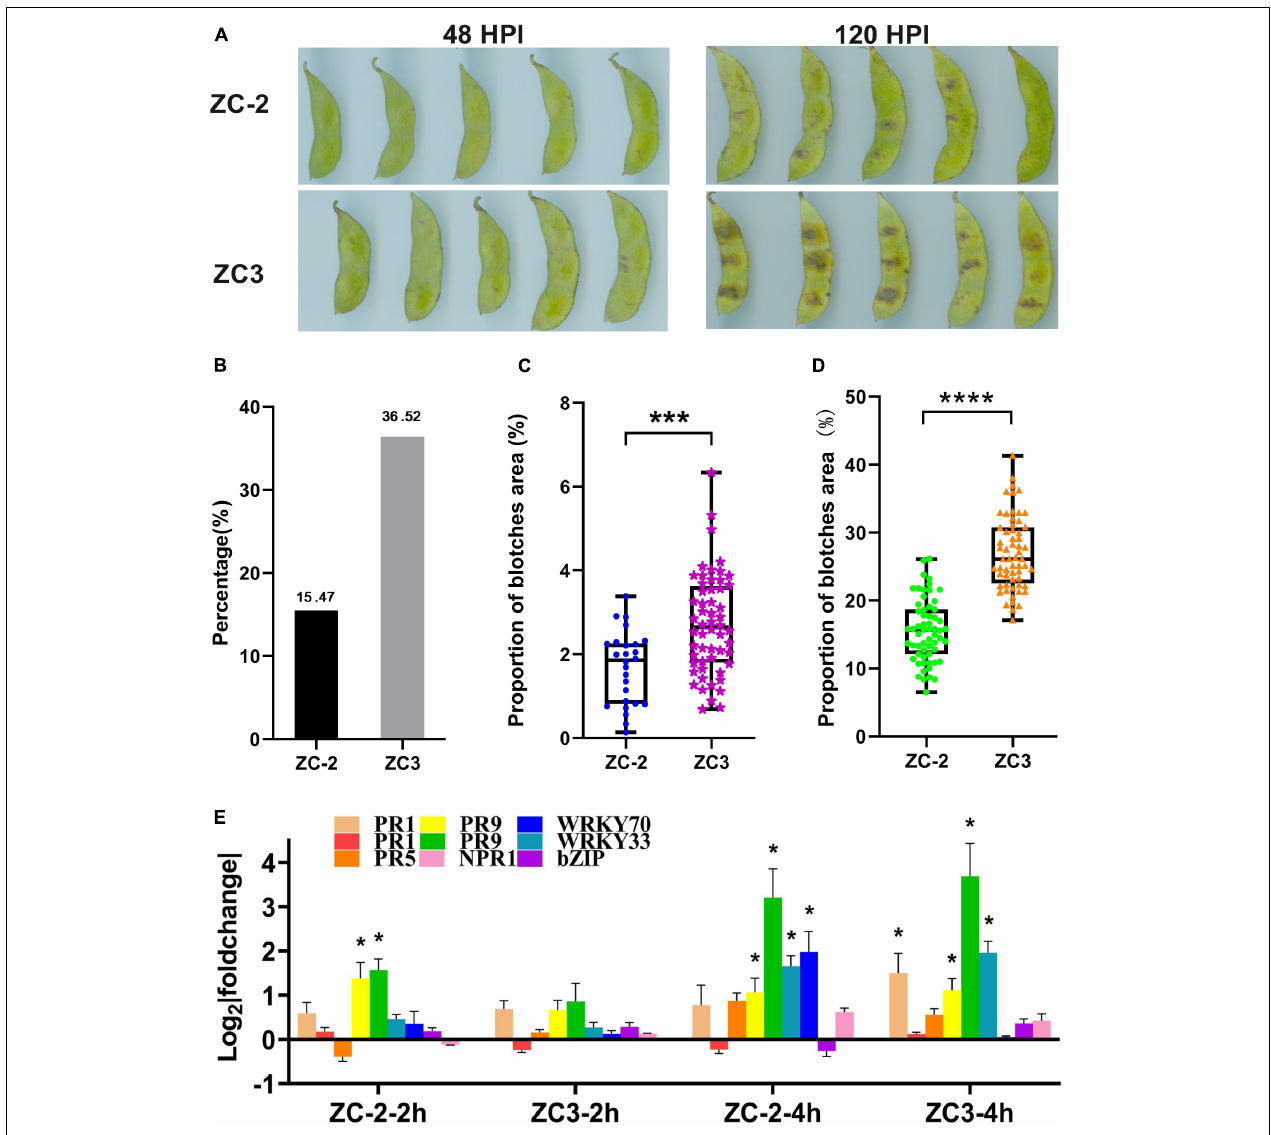
FIGURE 1 | (A) Symptoms of anthracnose on pods of soybean lines ZC-2 and ZC3 at 2 and 5 days after inoculation with Colletotrichum truncatum . (B) Statistics on the proportion of pods with anthracnose blotches at 2 days after inoculation. (C) Lesion area as a percentage of total pod area for each line at 2 days after inoculation ( n = 26, 59). *** p < 0.001. (D) Lesion area as a percentage of total pod area for each line at 5 days after inoculation ( n = 60). **** p < 0.0001. (E) Expression levels of nine disease-responsive genes detected by quantitative real-time PCR. The y -axis is the log 2 expression fold change and the x -axis represents the comparison groups. * p < 0.05. PR1 , pathogenesis-related protein 1 ( Glyma.15G062400 , Glyma.15G062500 ); PR5 , thaumatin-like protein ( Glyma.10G061000 ); PR9 , peroxidase ( Glyma.10G222400 ), ( Glyma.09G277800 ); WRKY33 ( Glyma.01G128100 ); WRKY70 ( Glyma.04G223300 ); bZIP , basic region-leucine